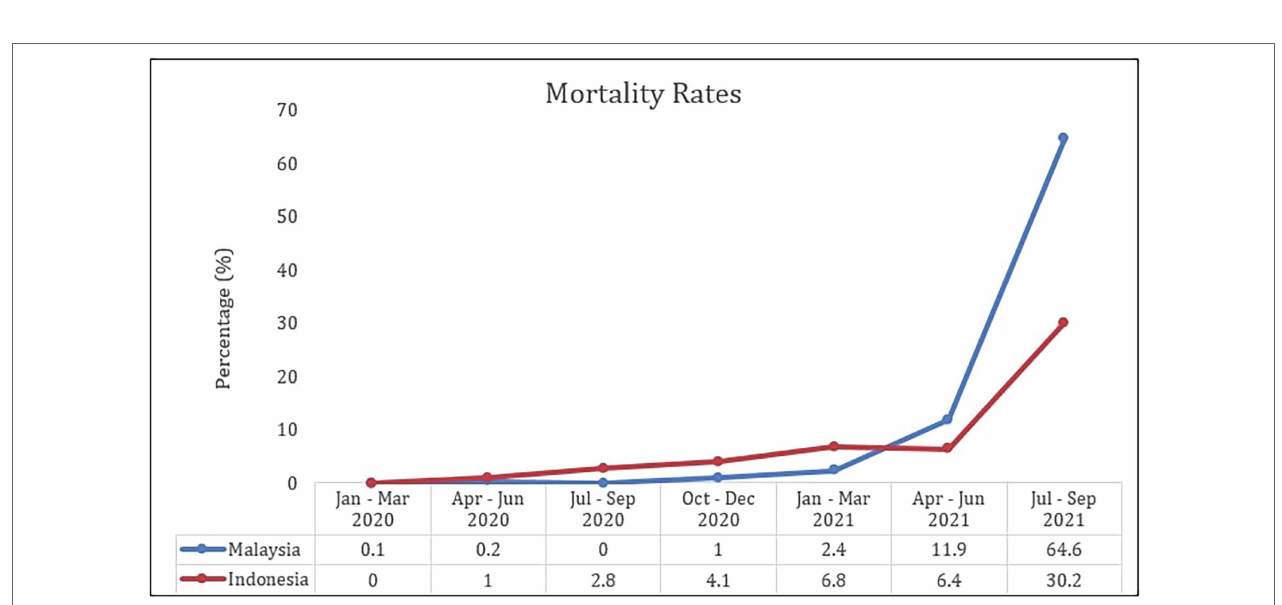
FIGURE 3 | Comparison of COVID-19 fatality rates in Malaysia and Indonesia (Rampal et al., 2021). *Case fatality rates, %, was delay adjusted to reflect a more valid population at risk of the case